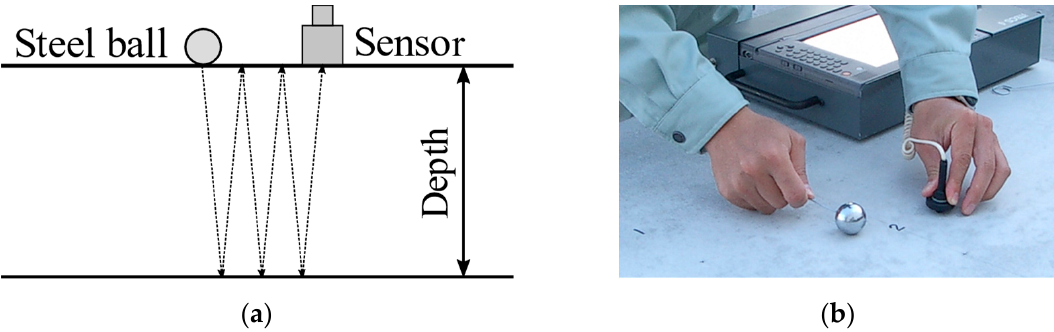
Figure 1. IEW method: ( a ) Schematic illustration of the IEW method; ( b ) Photograph of measurement status.